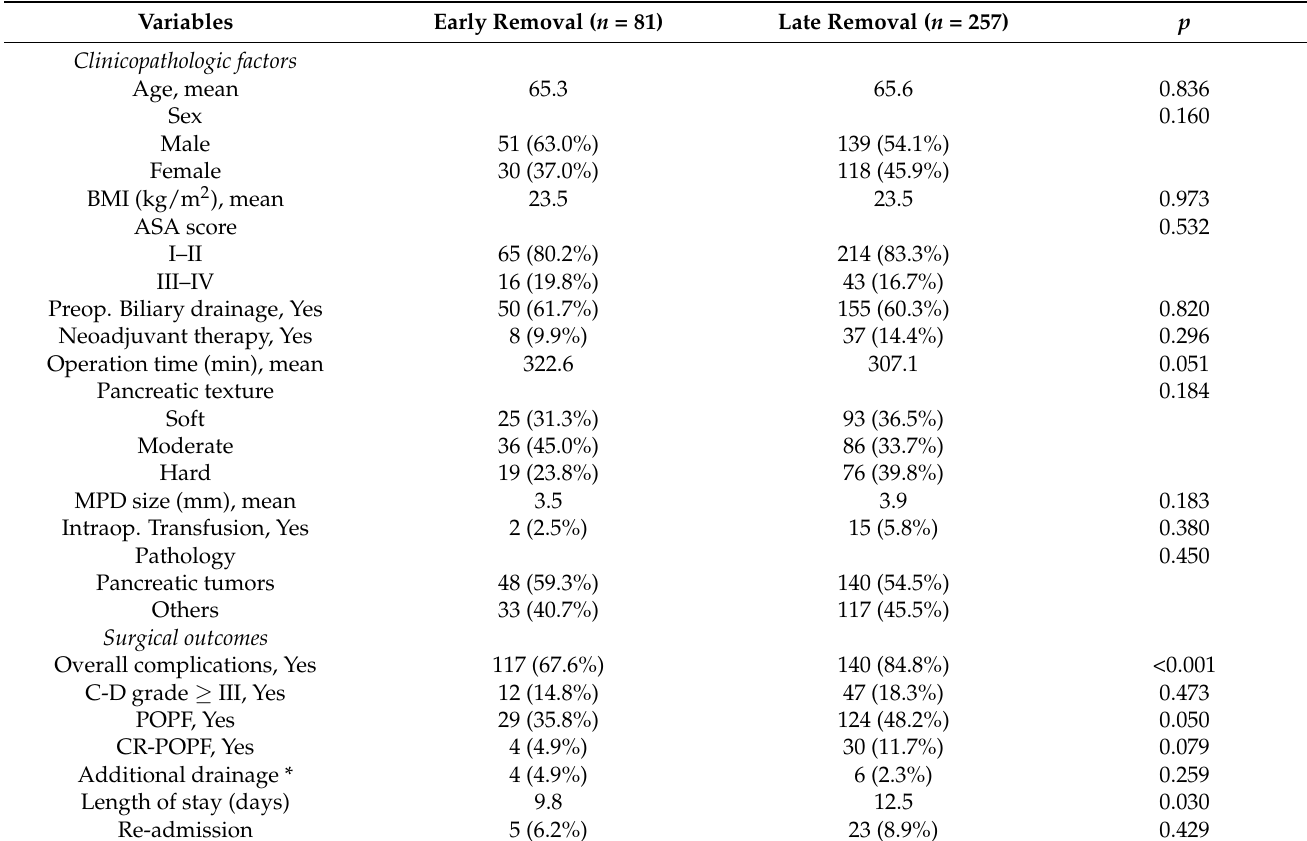
Table 3. Comparison of the early removal group and the late removal group in patients with POD1 DFA < 5000 IU ( n = 338).